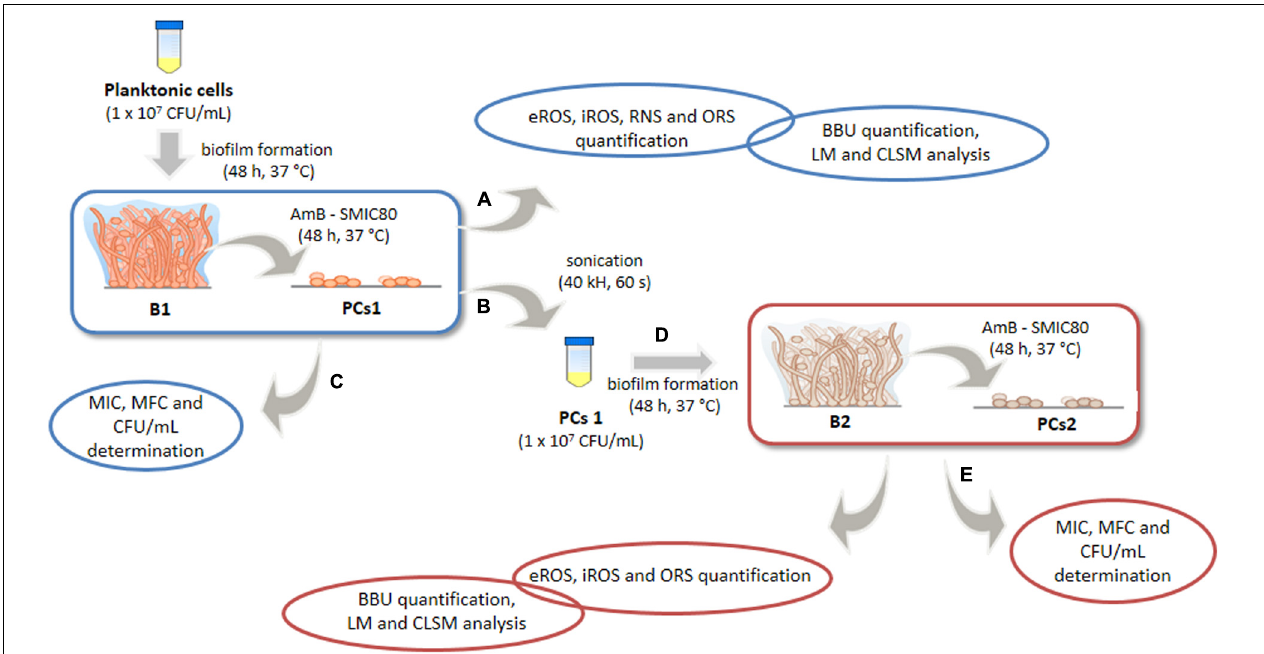
FIGURE 1 | Experimental model for the study of oxidative, nitrosative stress and antioxidant stress responses (OSR) of Candida tropicalis biofilms formed from planktonic or persister cells (PCs). Biofilm 1 (B1) was formed from planktonic culture and exposed to Amphotericin B (AmB, 200 µ g mL − 1 ), and biofilm 2 (B2) was formed from the PCs1 population that survived AmB treatment in B1 and was subsequently exposed to a second AmB treatment (200 µ g mL − 1 ). Biofilm biomass unit (BBU) was quantified by adhesion to a 96-well microplate and with crystal violet (CV) staining, and the PC fractions were determined by colony-forming units (CFU mL − 1 ). The minimum inhibitory concentration (MIC), the minimum fungicidal concentration (MFC) and the sessile minimum inhibitory concentration 80 (SMIC80) of AmB were determined. The extra and intracellular reactive oxygen species (eROS and iROS), reactive nitrogen species (RNS) and OSR from both biofilms were compared. Changes in biofilm structural parameters were analyzed by light microscope (LM) and confocal laser scanning microscopy (CLSM) using COMSTAT image-analysis